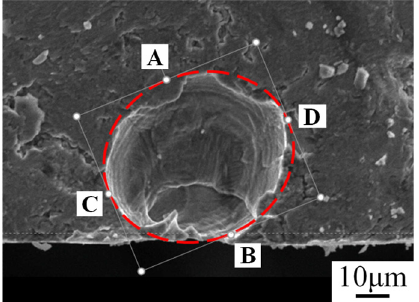
Figure 10. Defect at fatigue crack initiation site of EBMed Ti-6Al-4V ( σ a = 450 MPa, N f = 2.8 × 10 5 ).